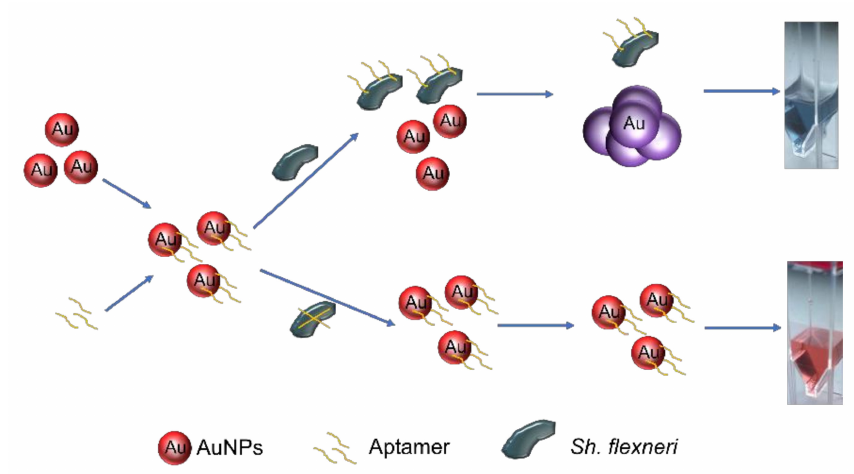
Figure 13. Scheme of the colorimetric detection of Sh. flexneri . Reprinted with permission from ref. [135]. Copyright 2019,